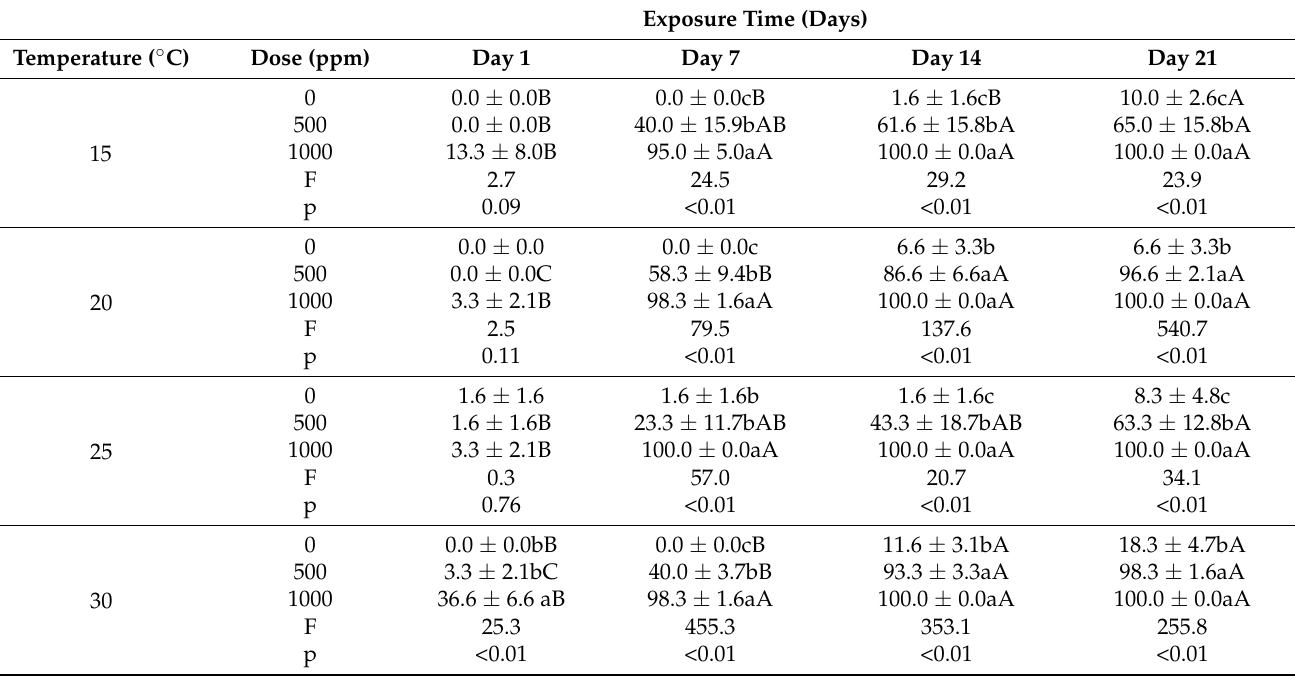
For each exposure time and temperature, mortality means followed by the same lowercase letter do not differ significantly according to the Tukey–Kramer HSD test at p < 0.05, in all cases df = 2,17. For each dose and temperature, mortality means followed by the same uppercase letter do not differ significantly across treatments according to the Tukey–Kramer HSD test at p < 0.05. Where no letters exist, no significant differences were noted. ANOVA parameters for dead adults were: at 15 ◦ C and 0 ppm, F = 9.7, p < 0.01, at 15 ◦ C and 500 ppm, F = 4.7, p = 0.01, at 15 ◦ C and 1000 ppm, F = 81.0, p < 0.01, at 20 ◦ C and 0 ppm, F = 2.6, p = 0.08, at 20 ◦ C and 500 ppm, F = 54.5, p < 0.01, at 20 ◦ C and 1000 ppm, F = 1279.4, p < 0.01, at 25 ◦ C and 0 ppm, F = 1.4, p = 0.26, at 25 ◦ C and 500 ppm, F = 4.3, p = 0.02, at 25 ◦ C and 1000 ppm, F = 2102.5, p < 0.01, at 30 ◦ C and 0 ppm, F = 10.2, p < 0.01, at